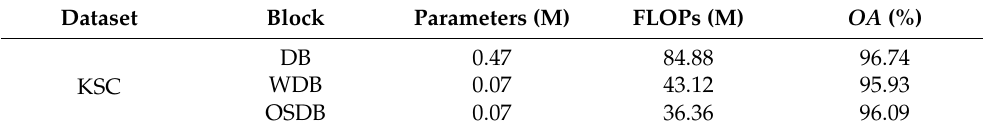
Table 18. The number of parameters, FLOPs, and OA of different dense blocks on the KSC dataset. Dataset